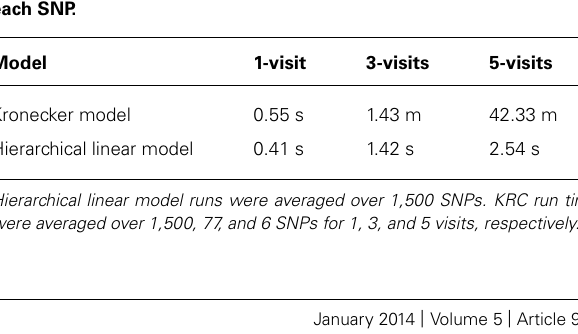
effects, B for GEI effects, and C for joint 2 df genetic and GEI effects). Similarly, the 2nd row corresponds to the 5-visits results ( D for genetic main effects, E for GEI effects, and F for joint 2 df genetic and GEI effects).